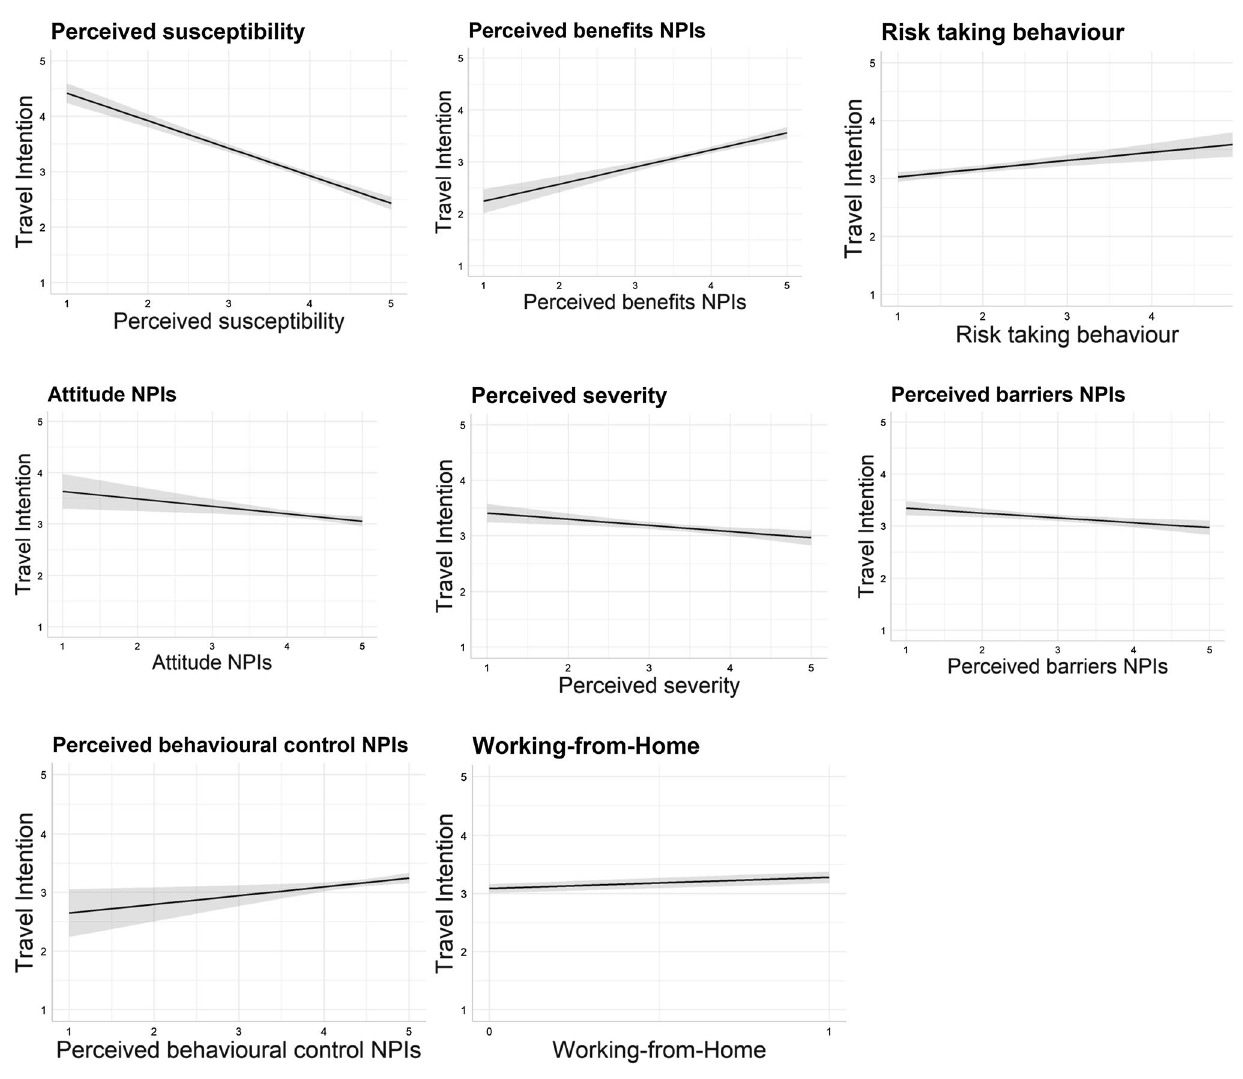
Fig. 2 Effect plots of effect size* in absolute